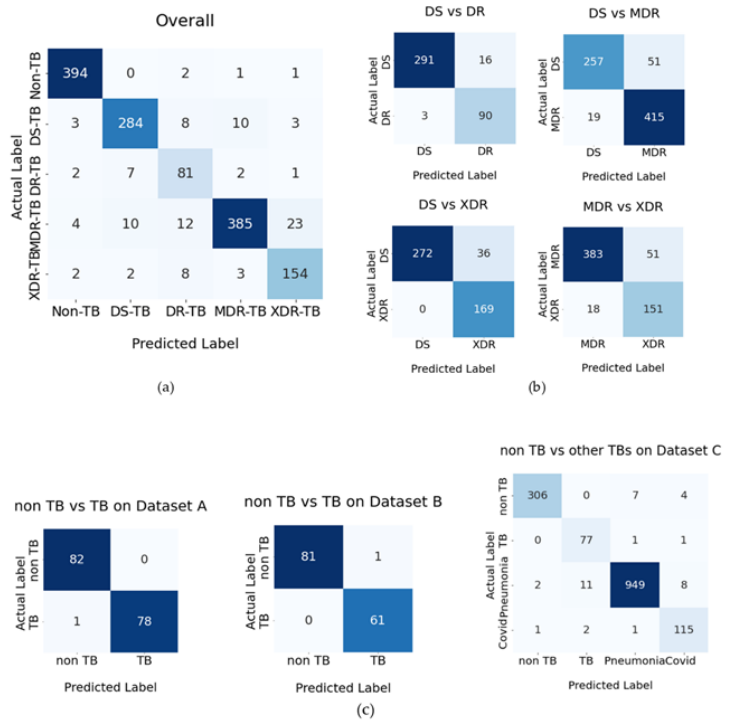
Figure 1. Confusion matrices of the classification. ( a ) Overall result of five classifications, ( b ) the results of the comparison of drug resistance, and ( c ) the results of comparison for non-TB vs. other classifications on datasets A, B, and C.